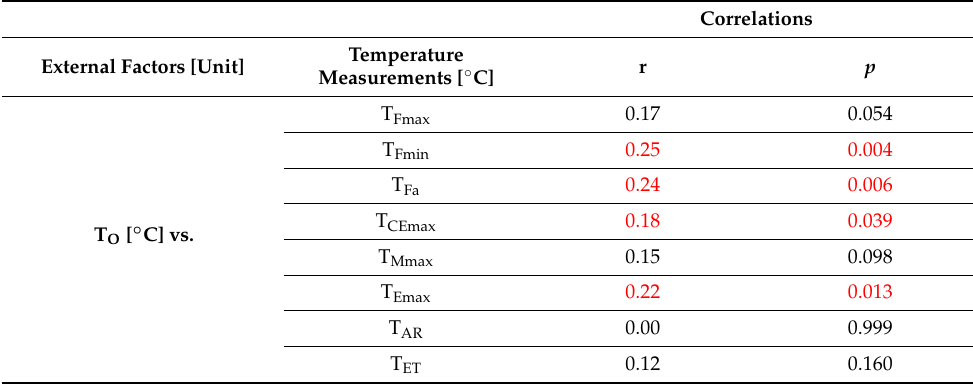
Table 2. Correlations between external factors and temperature values. The statistically significant differences were marked with red